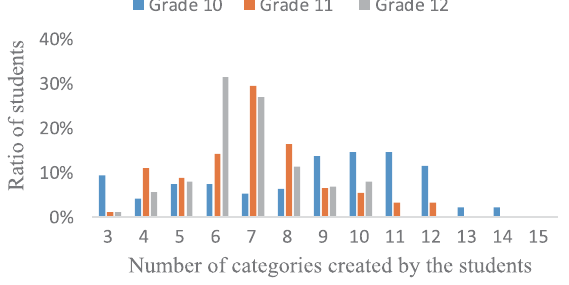
FIG. 3. The distribution of the number of categories created by students in different grades. The horizontal axis is the number of categories created by the students, and the vertical axis is the percentage of students in different grades (grade 10-blue, grade 11-orange, grade